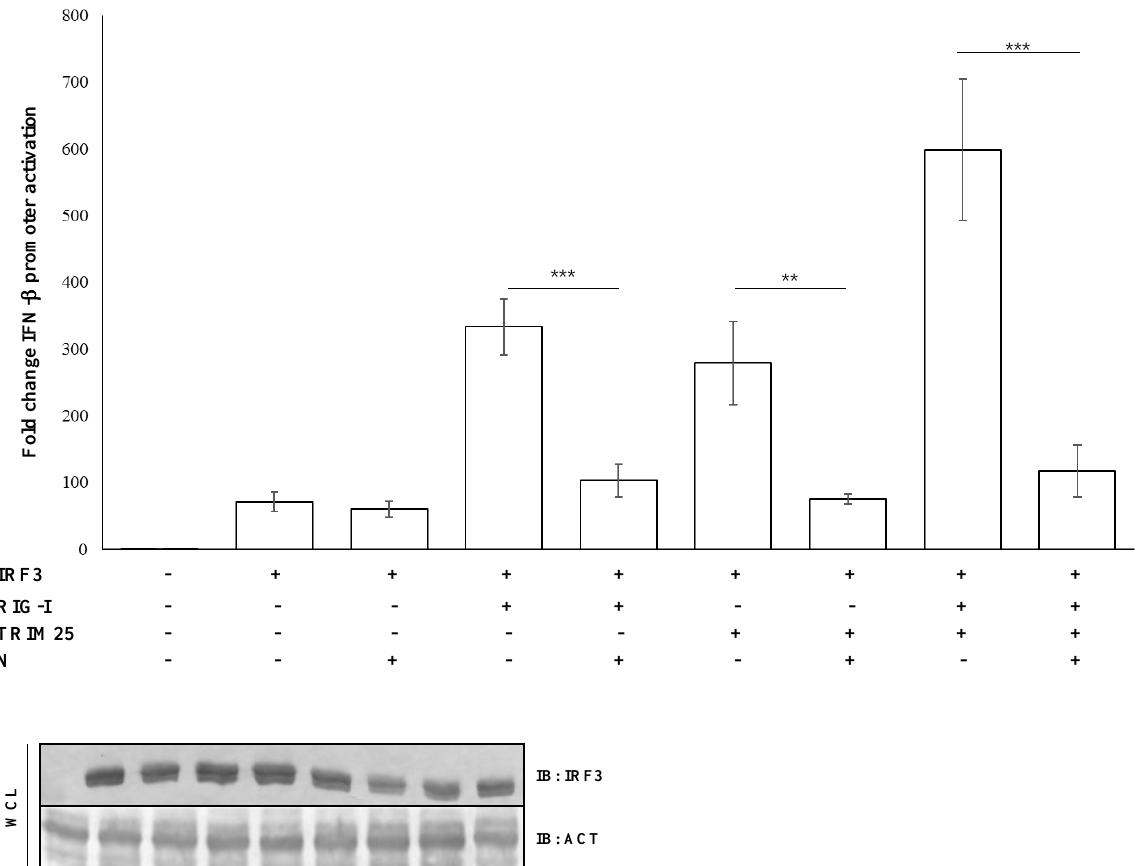
Figure 3. IRF3 activation is impaired due to inhibition of the RIG-I-TRIM25 pathway. Lenti-X 293T cells were co-transfected with the IFN- β -Luc Firefly luciferase reporter plasmid and the Renilla luciferase control reporter plasmid along with the IRF3-expressing plasmid. Where indicated, co-transfections were performed, including expressing plasmids for RIG-I, TRIM25 or SARS-CoV-2 N. Cells, previously stimulated for 12 h with poly(I:C), were collected at 48 h post-transfection. The luciferase activity of the cell lysates was analyzed with the dual luciferase reporter assay system (Promega). Fold changes in IFN- β promoter activation were calculated with respect to the relative reference sample based on Firefly luciferase values normalized to Renilla luciferase activities. Results were plotted as mean values ( n = 4) ± standard deviation (SD) and significance was determined by p -value (*** p < 0.005, 0.005 < ** p < 0.01). Cell lysates from reporter gene assays were analyzed by